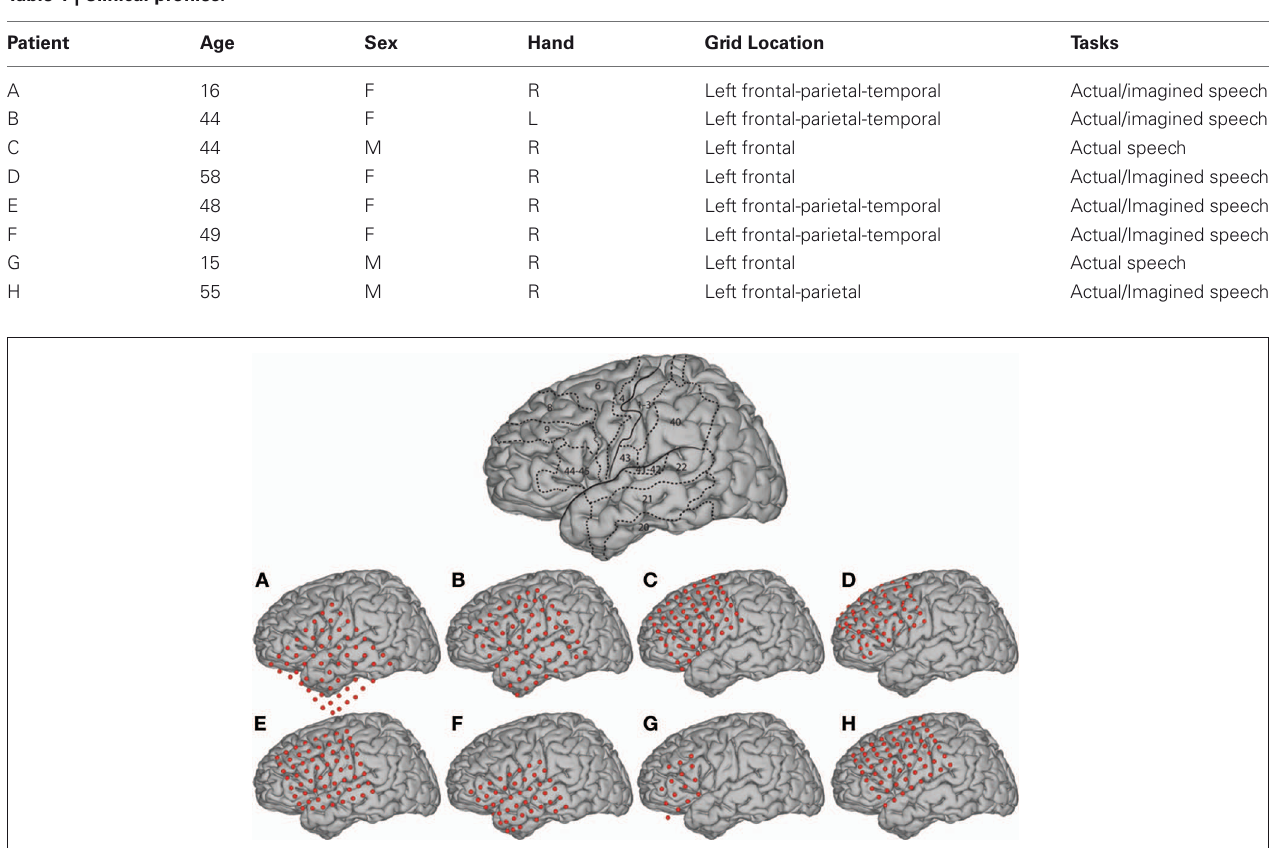
FIGURE 2 | Electrode locations. The brain template on the top highlights the location of the central sulcus and Sylvian fissure, and also outlines the approximate location of relevant Brodmann areas.